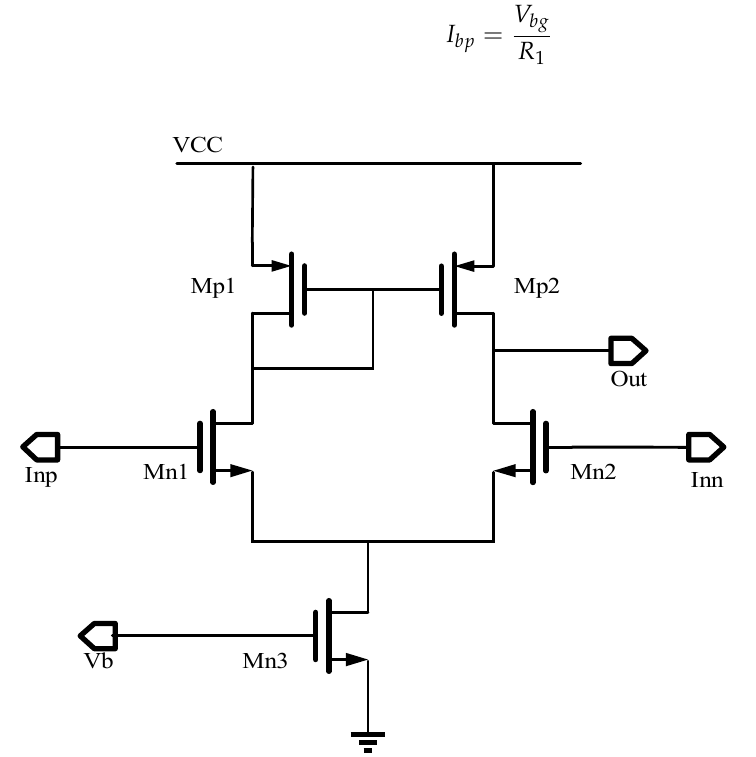
Figure 11. The principle of the improved amplifier.